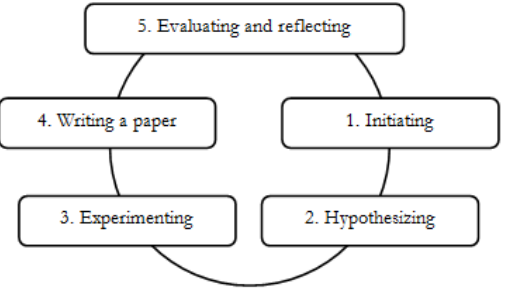
Figure 1. Learning Cycle in the REORCILEA